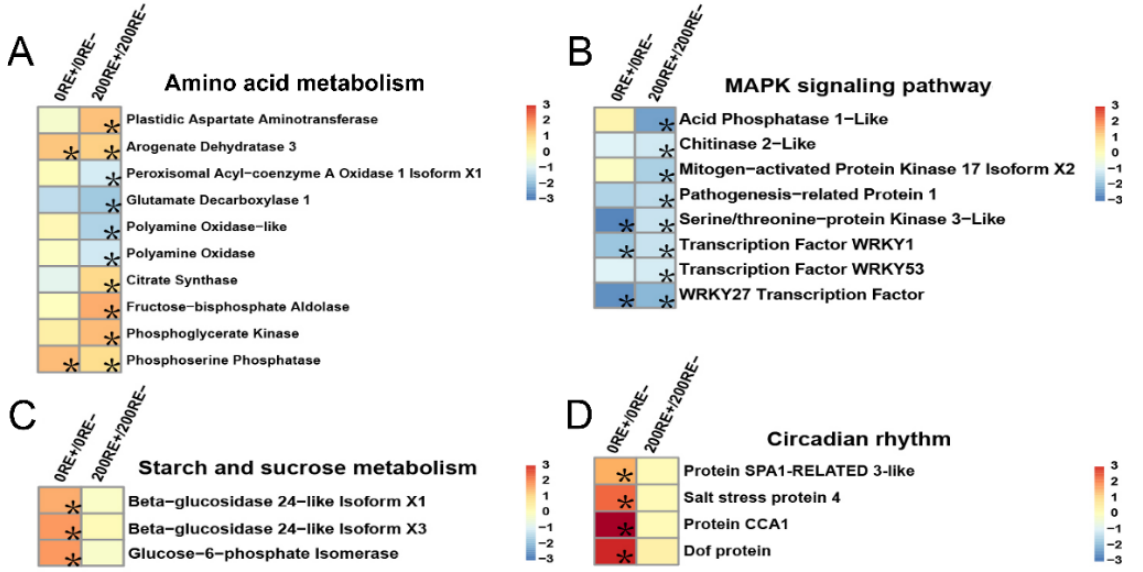
Figure 5. Clustering of DEGs associated with amino acid metabolism ( A ), MAPK signaling pathway ( B ), starch and sucrose metabolism ( C ) and circadian rhythm ( D ) between 0RE+ and 0RE − and between 200RE+ and 200RE − . Color panels stand for log 2 (fold change). Asterisks indicate statistically significant changes with FDR < 0.01 and fold change ≥ 2. 3.6. NaCl Treatment Alters Expression of Main Gene Related to Amino Acid Metabolism,